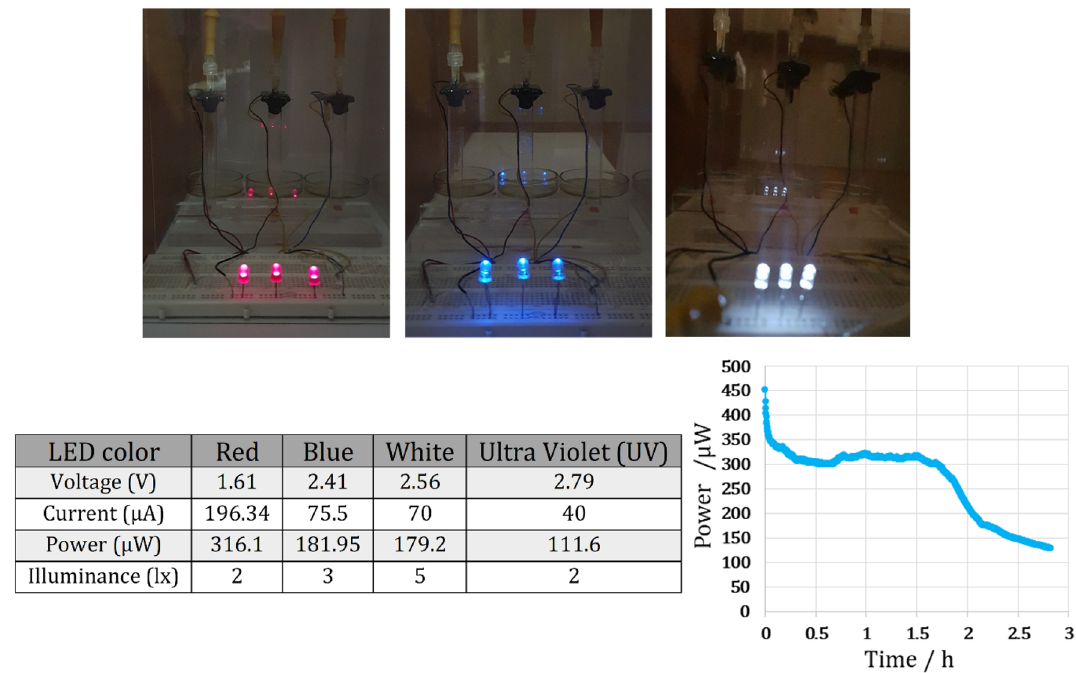
Figure 7. The performance of the Zn-anode microfluidic MFC inoculated with Shewanella oneidensis MR-1 to power LEDs.